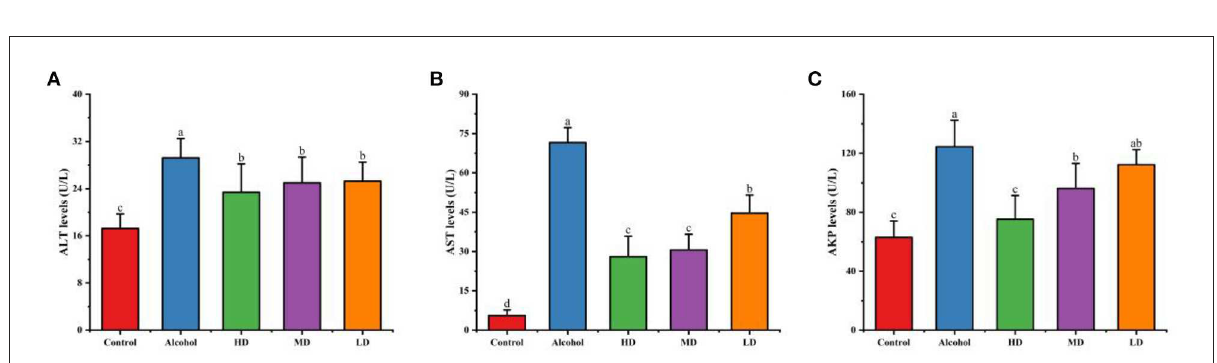
FIGURE6 Effect of methanolic extract of lotus root on the levels of ALT (A) , AST (B) , and AKP (C) in the serum of mice with acute alcohol intoxication. Different letters represent significant differences between groups (N = 10, p < 0.05).